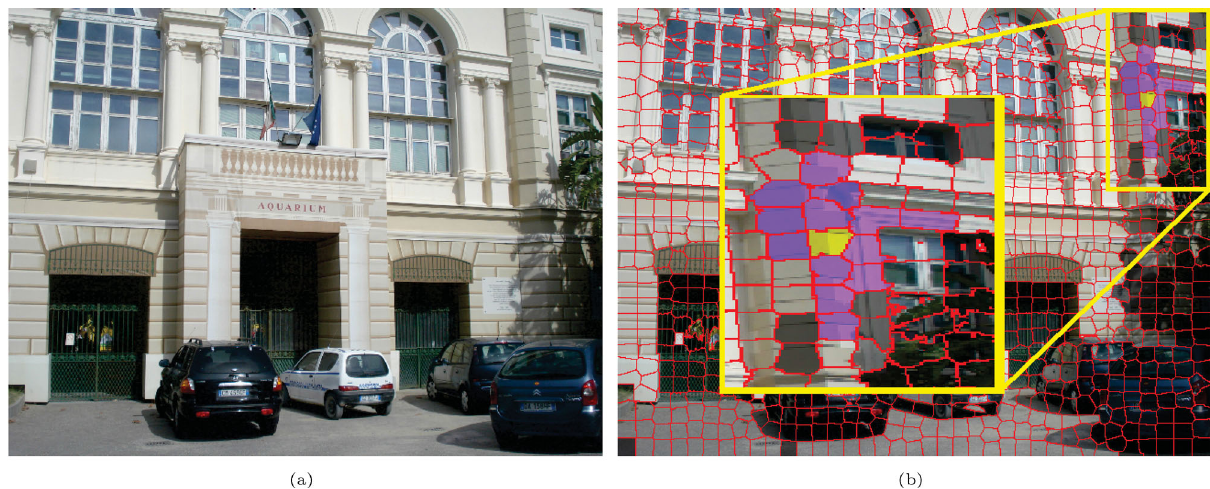
Fig. 5 Generating new labels for unreliable superpixels. (a) Original input image I 1 . (b) Searching for similar superpixels in R . Dark regions: unreliable superpixels. Yellow: unreliable superpixel to be processed. Blue: most similar superpixels found in R to the yellow